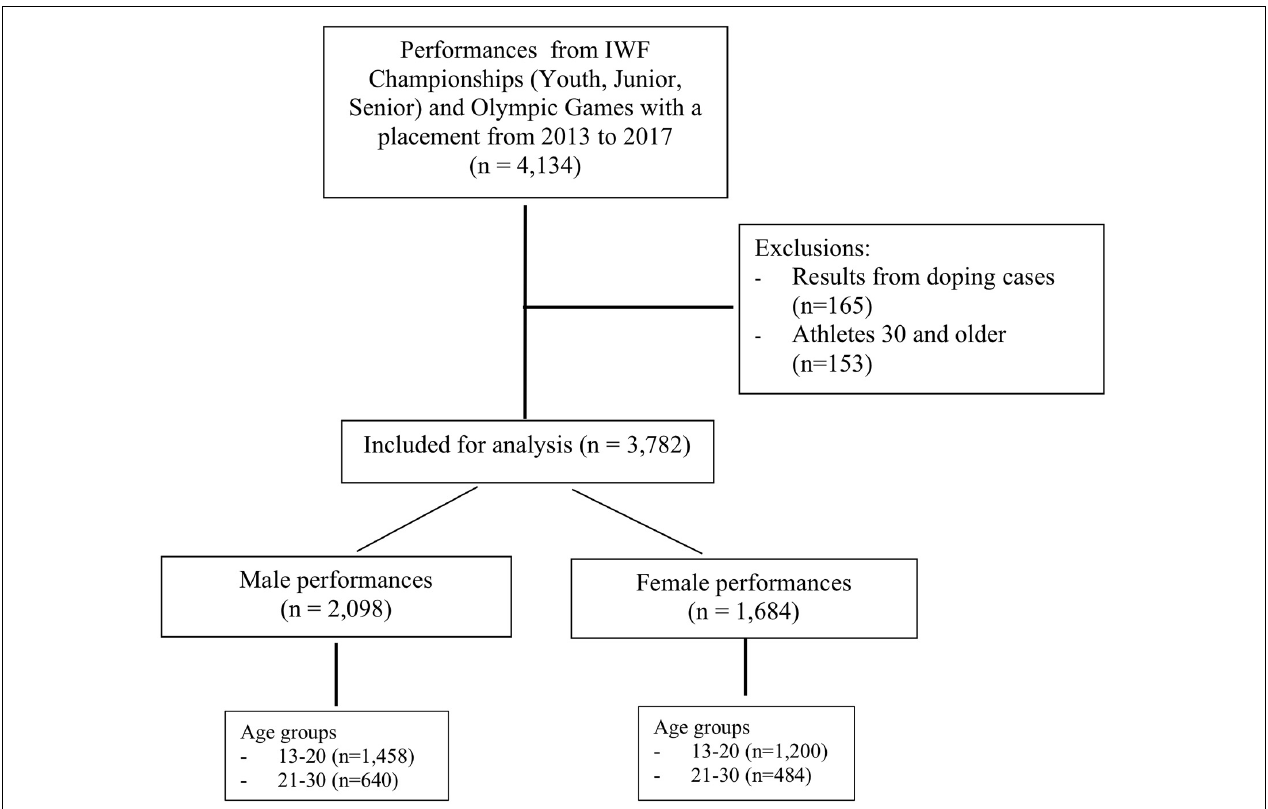
FIGURE 1 | STROBE flow diagram.